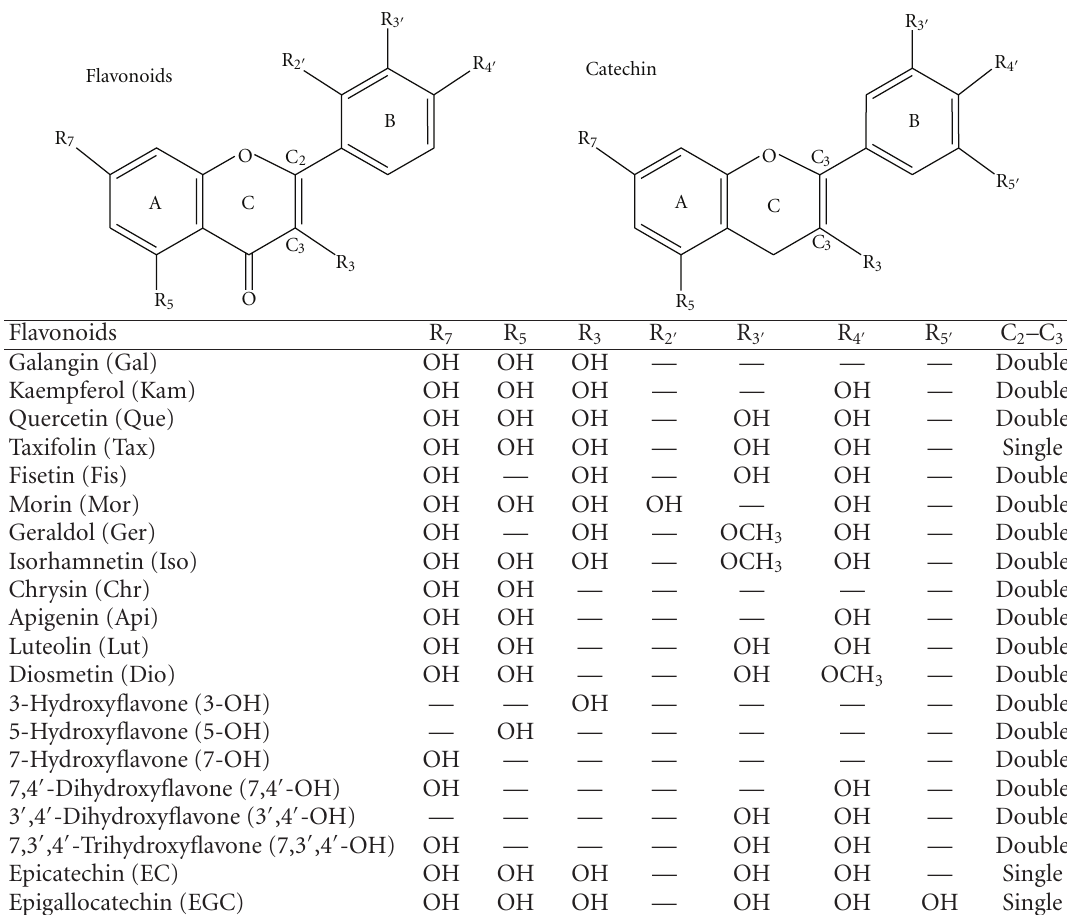
Figure 1: Structure of